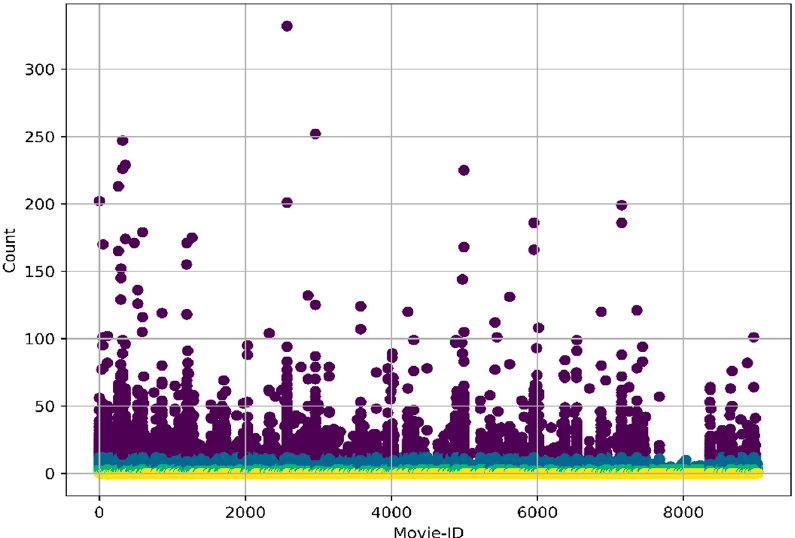
Figure 8. Vertical clustering of the dataset on the basis of per-day count of the Movie-ID